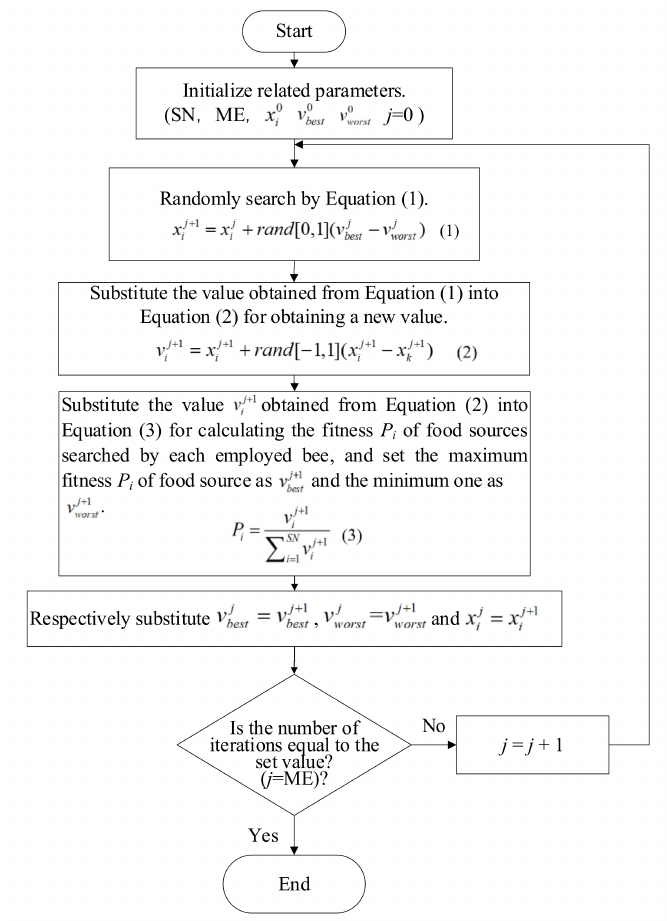
Figure 3. Flowchart of the traditional ABC